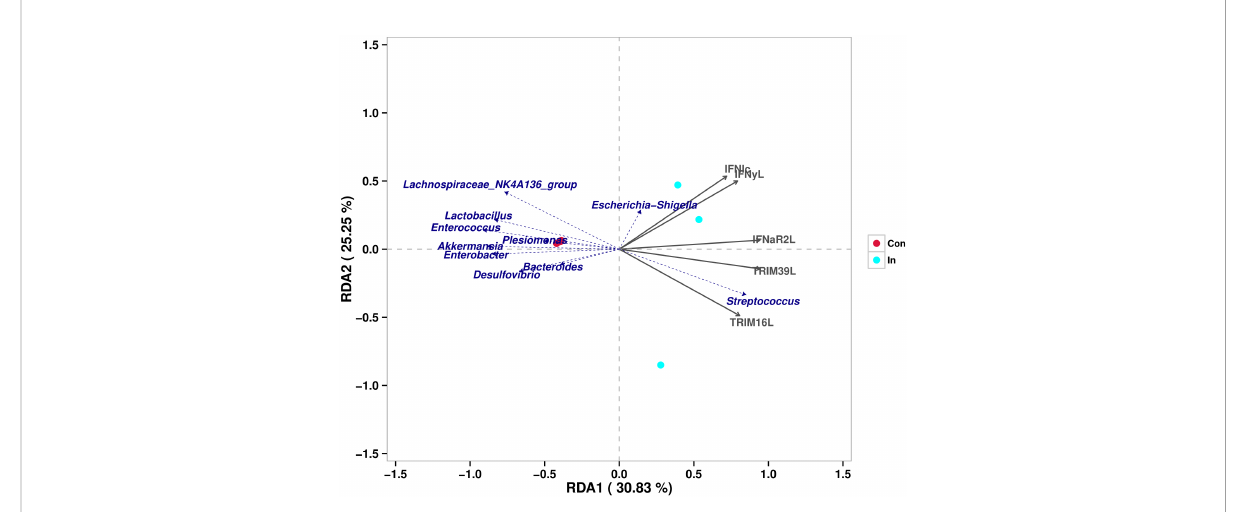
FIGURE 7 Redundancy analysis of the correlation between different intestinal microbes and interferon-related differentially expressed